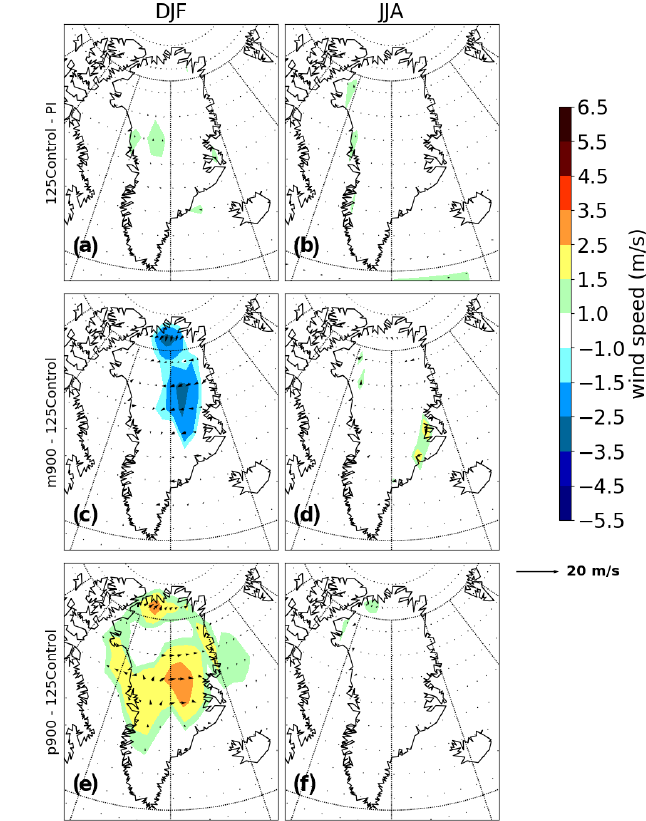
Figure A3. Winter (DJF) and summer (JJA) low-level wind (at 850hPa) anomalies for m900 (c–d) and p900 (e–f) compared to the 125Control simulation. Also shown are low-level wind anoma- lies for 125Control compared to the PI simulation (a–b) . Only the anomalies statistically significant at the 95% confidence level are displayed. Shading displays wind speed (ms − 1